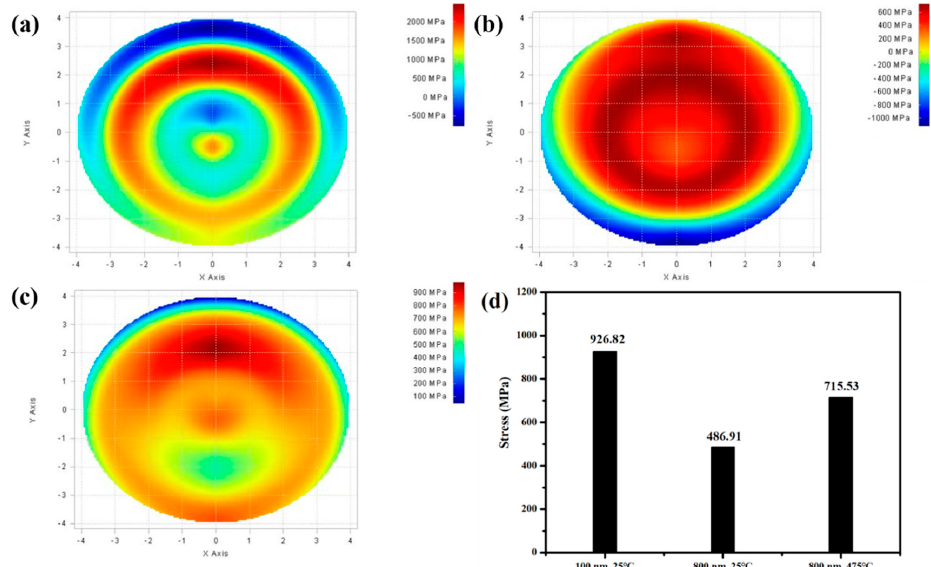
Figure 3. Stress distribution of FeCo thin films with different thicknesses and deposition temperatures: ( a ) 100 nm, 25 °C, ( b ) 800 nm, 25 °C, ( c ) 800 nm, 475 °C; and ( d ) the average stress.